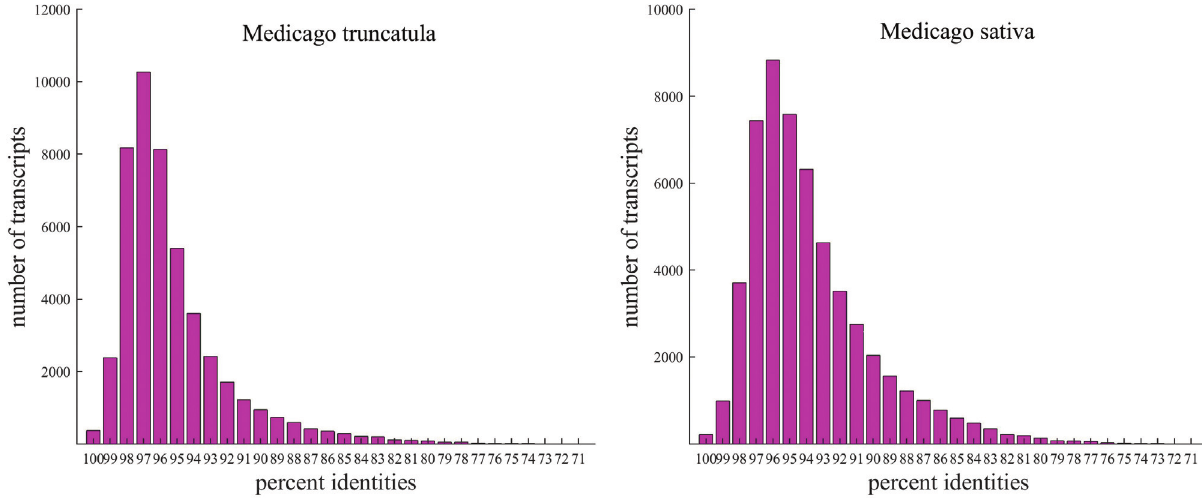
Figure 1 - Sequence identity distributions of unique Medicago ruthenica transcripts against M. truncatula and M. sativa (alfalfa). The X-axes show the percent similarity of Medicago ruthenica transcripts to the two other Medicago species, and the Y-axes show the numbers of transcripts. The results of this analysis show that transcribed genes from M. ruthenica are highly similar to genes from both M. truncatula and alfalfa.